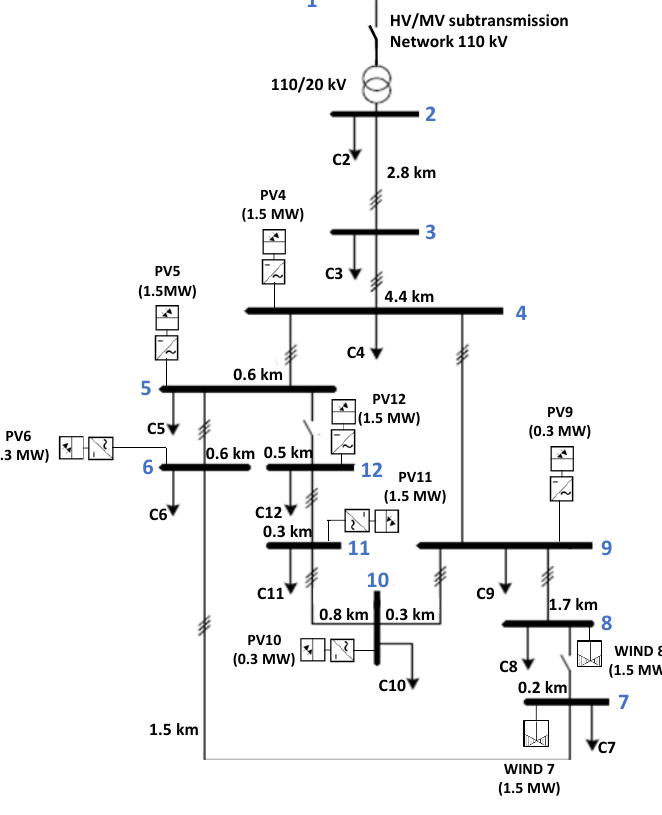
Figure 7. Simulation grid. Table 1. P and Q operating point of consumers and generators.